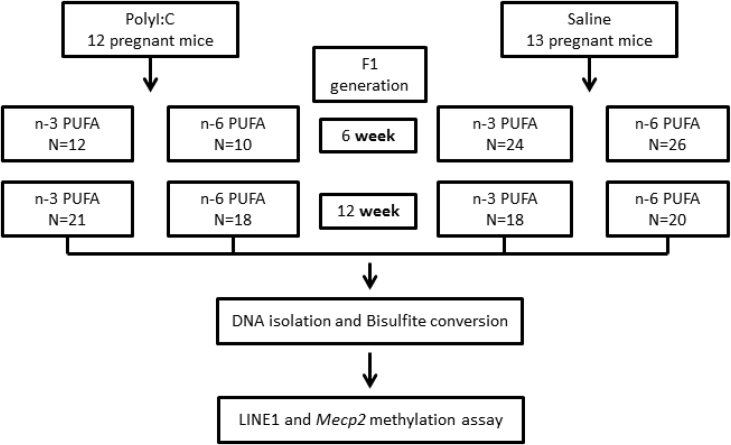
Study design for epigenetic profiling of the MIA mouse model following dietary intervention.